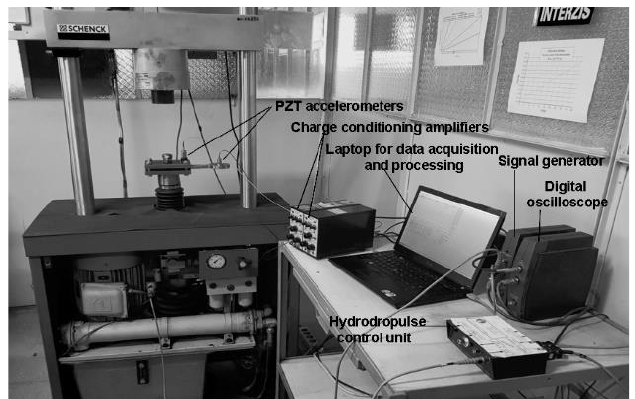
Figure 3. Testing rig and equipment for measurement, acquisition and processing of experimental data.